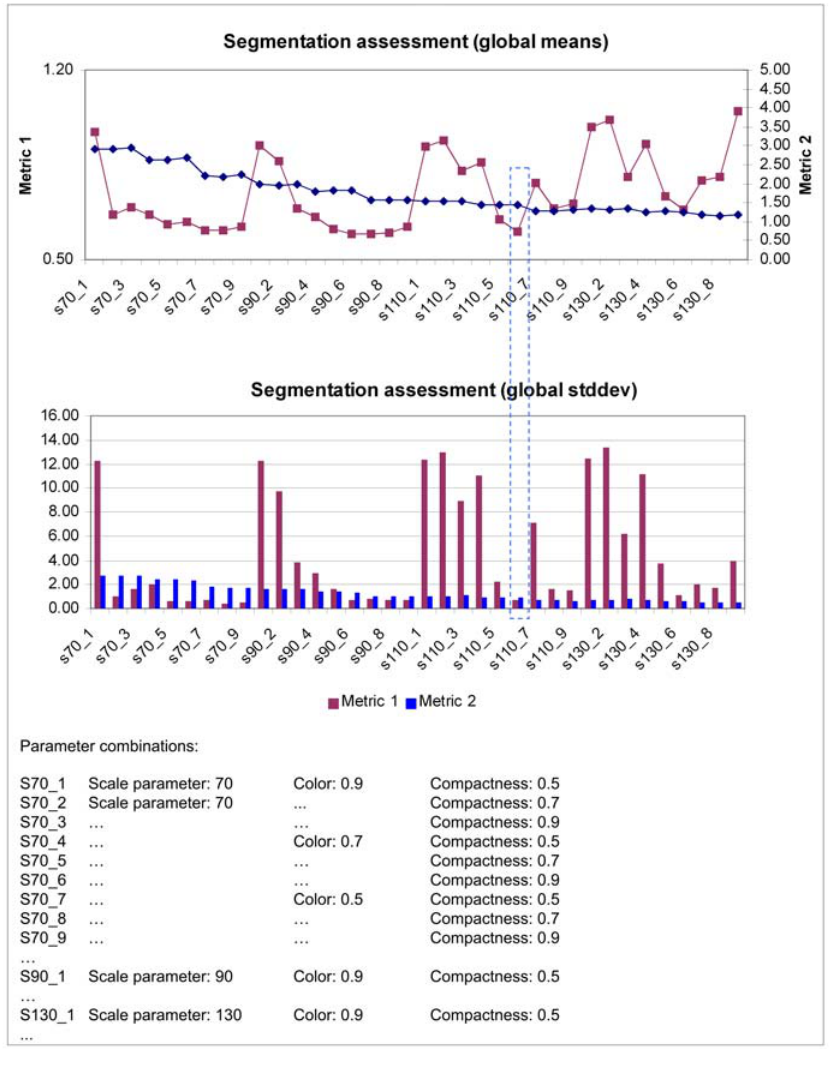
Figure 8. Assessment of SPOT segmentation settings. Note: Metric 1 and metric 2 are colored red and blue, respectively. The upper plot shows the mean values, the lower plot the standard deviations. The legend explains the labeling of the x-axes for the different settings (scale, color,